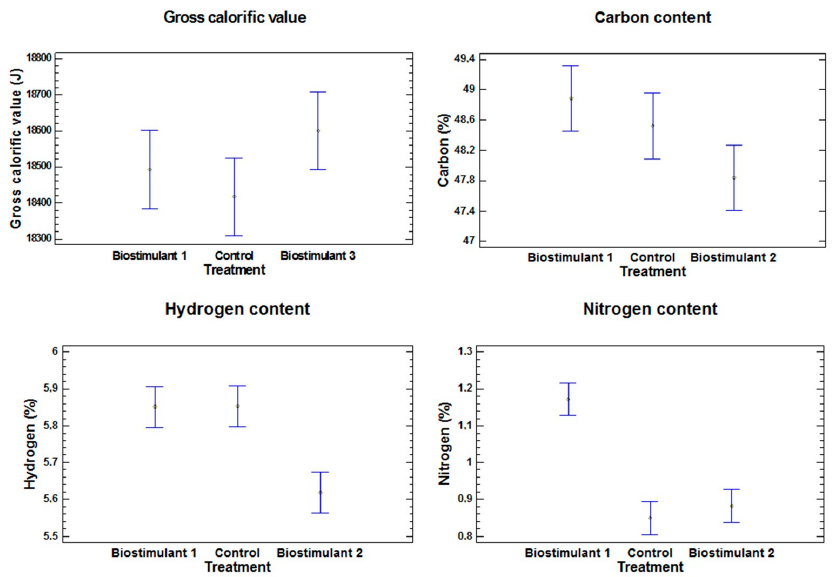
Figure 4. LSD intervals at 90% level of confidence in the influence of the treatment factor in residual biomass characteristics. ( n = 108).